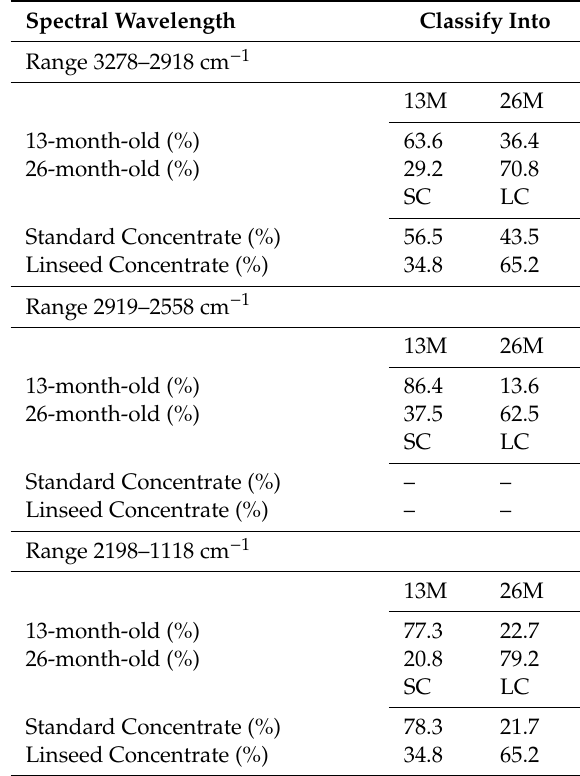
Table 3. Classification matrix from MIR spectrum of 13- and 26-month-old Galician Mountain x Burguete crossbred foals (13M, 26M) and supplemented with standard and linseed concentrate (SC, LC). Discriminant analyses results after selecting the most suitable wavelength range from the prediction